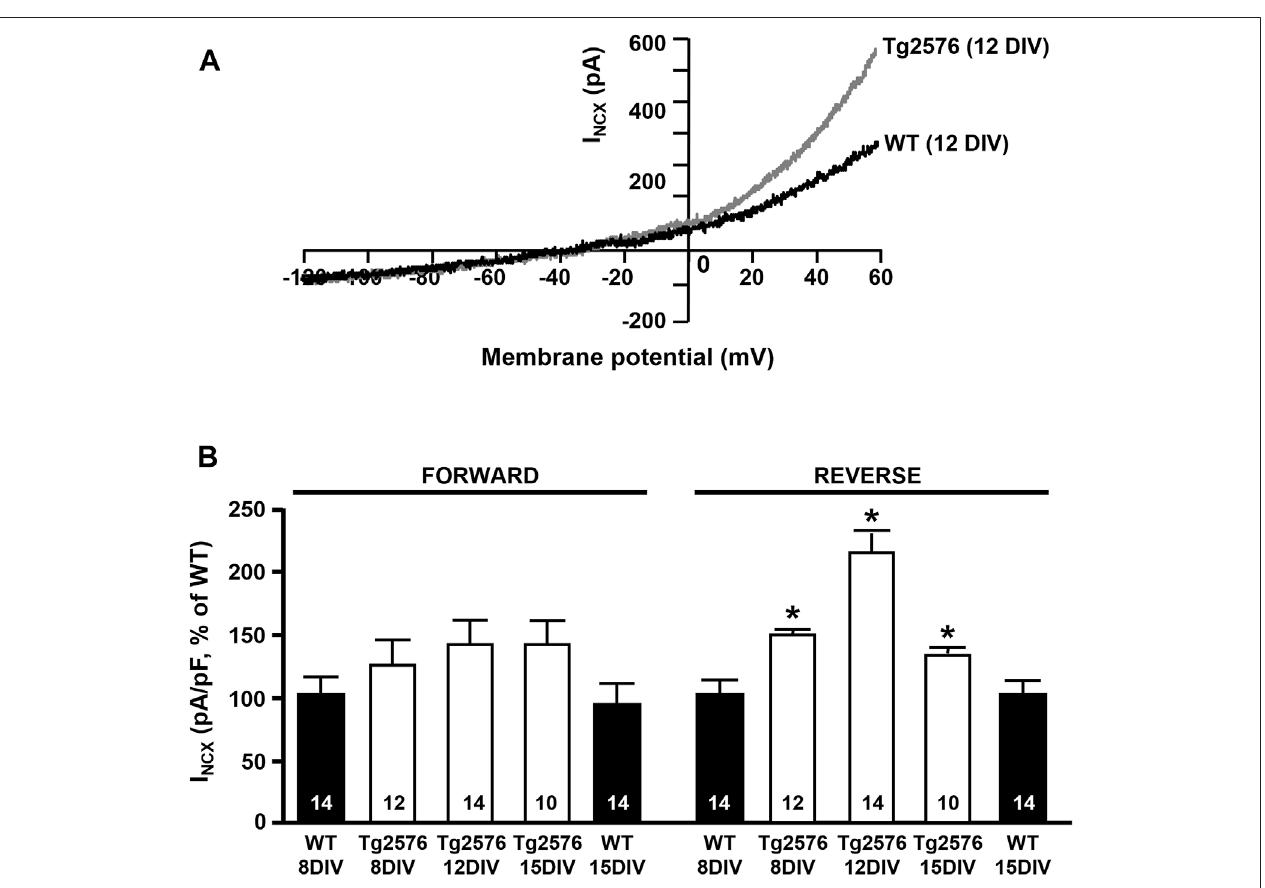
FIGURE1 | I NCX in WT and Tg2576 primary hippocampal neurons. (A) Representative superimposed traces of I NCX inthe reverse and forwardmodes ofoperation recorded in WT (black trace) and Tg2576 (gray trace) primary hippocampal neurons at 12 DIV. (B) Quanti fi cation of I NCX in the reverse and forward modes of operation recorded in WT and Tg2576 primary hippocampal neurons at 8, 12, and 15 DIV, expressed as percentage of increase in comparison to WT. Values are expressed as mean ± SEM of 3 independent experimental sessions. Statistical comparisons between groups were performed by one-way ANOVA followed by Newman-Keuls ’ test. (* p < 0.05 vs. WT). The number of cells used for each experimental condition is noted on the